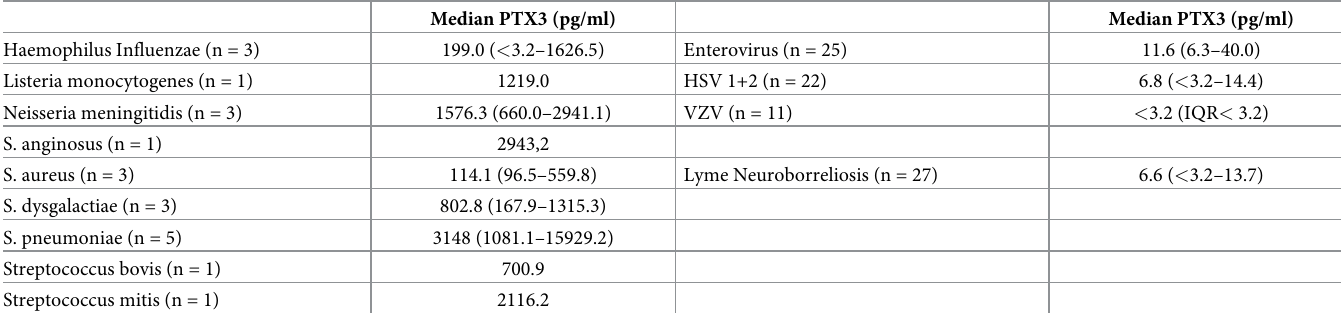
Table 3. PTX3 concentration in CSF based on